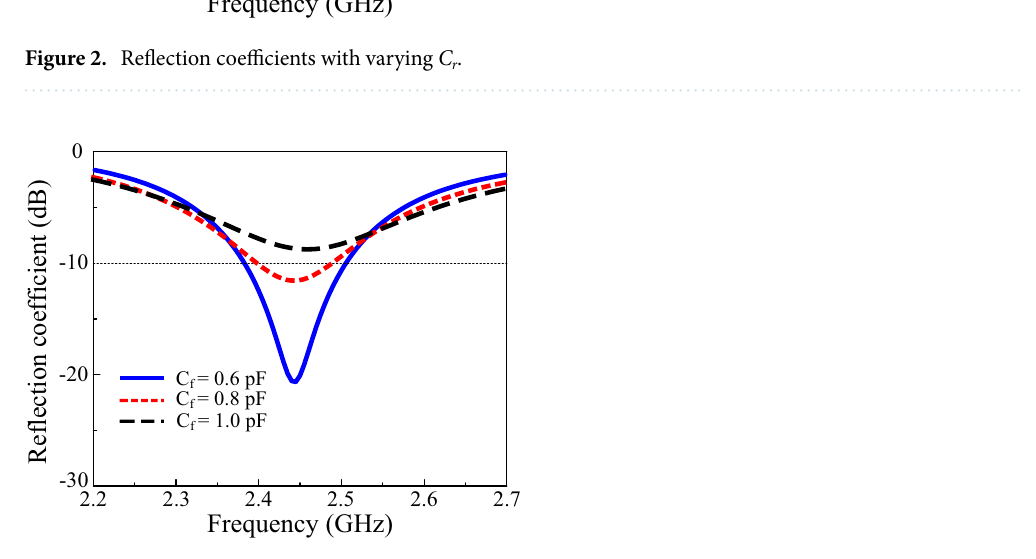
Figure 3. Reflection coefficients with varying C f